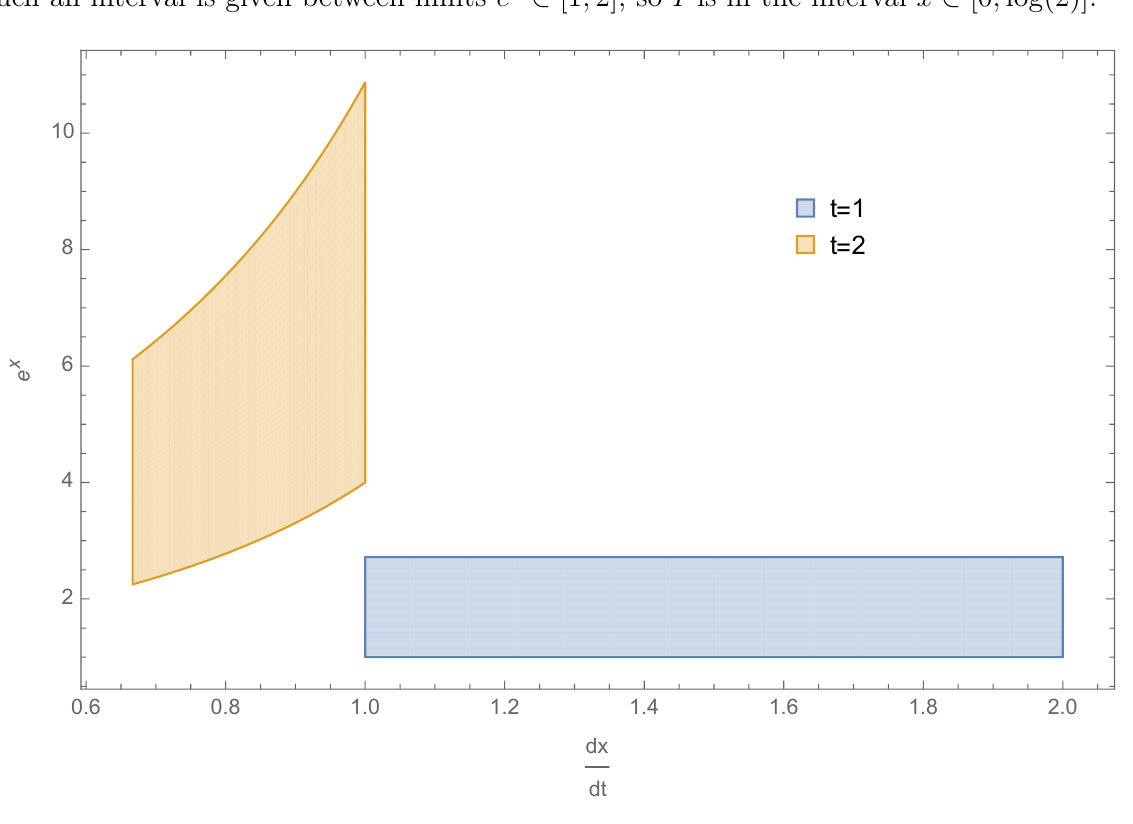
FIG. 1: The space in the ˙ x − x plane occupied by our set of solutions at the initial time t = 1 (blue) and later time t = 2 (yellow). We see that the phase space area has been conserved, as per Liouville’s theorem, but the shape occupied has changed. It is from this relative stretching that we recover the probability weighting of solutions spread in x